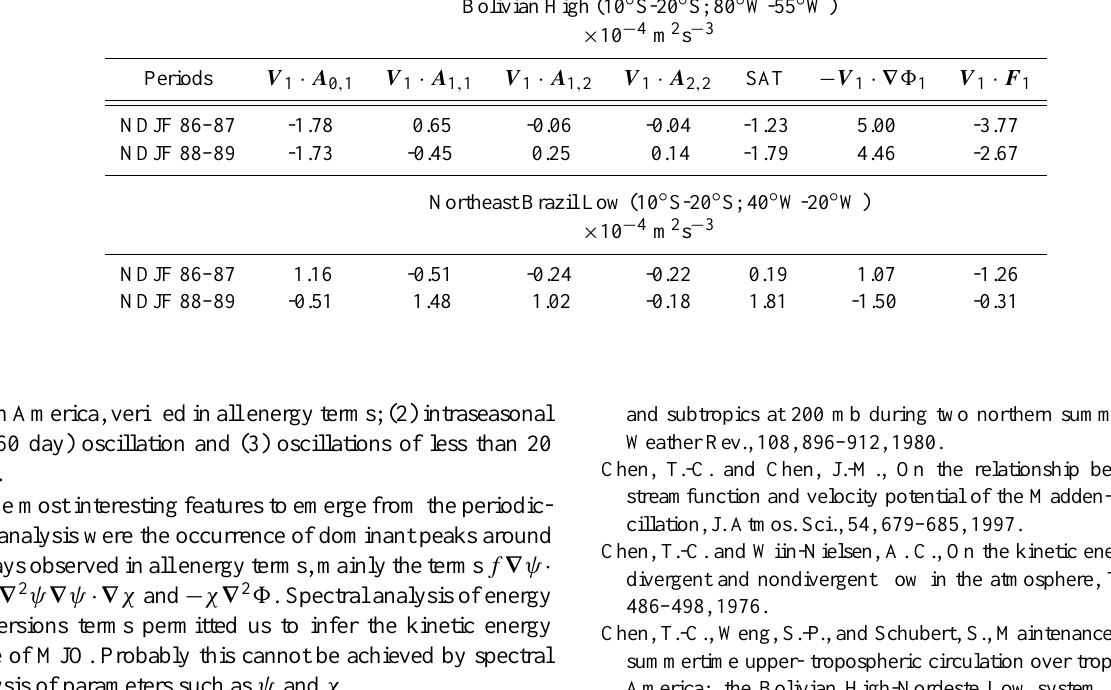
Table 4. Average contributions of the local energy balance equation terms, in summers of 1986–1987 and 1988–1989. Values are expressed in 1 . 0 × 10 − 3 m 2 s −